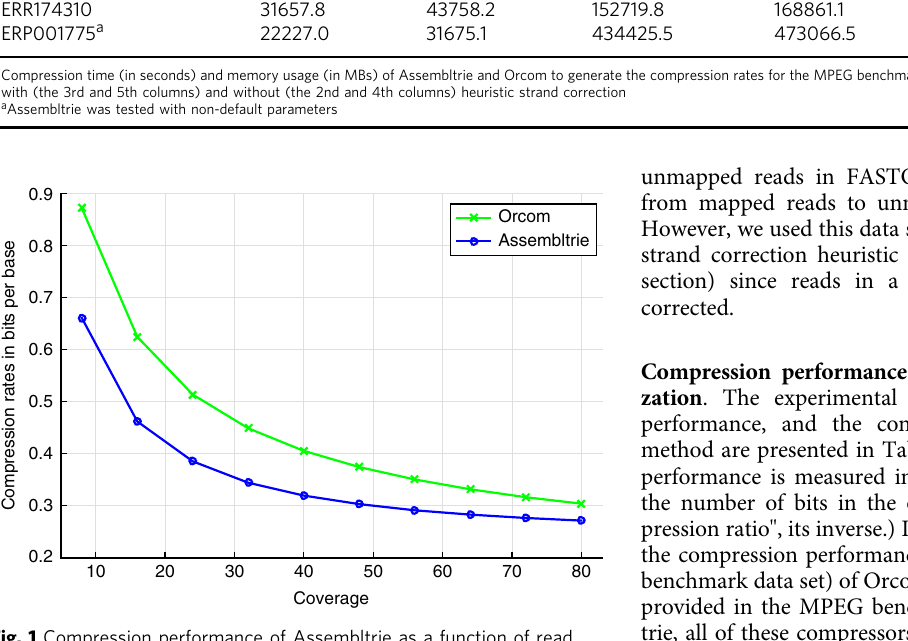
Fig. 1 Compression performance of Assembltrie as a function of read coverage. The compression performance (with 8 threads) of Assembltrie in comparison to Orcom on downsampled read collections from SRR327342 — as a function of